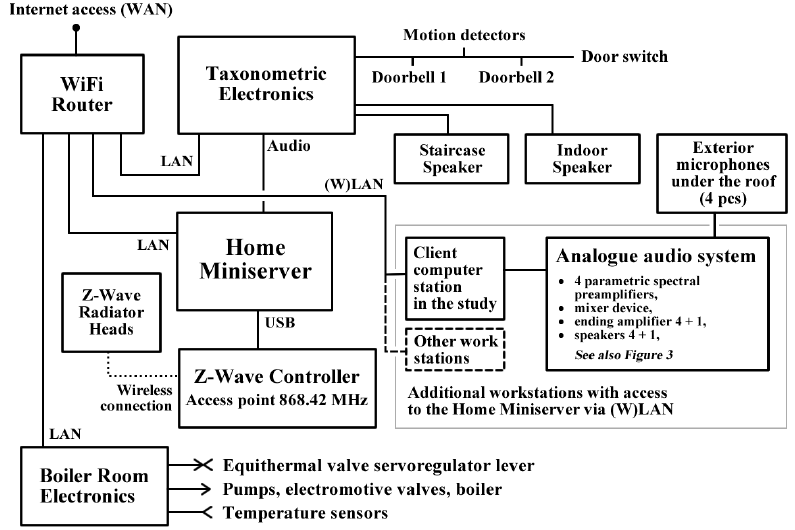
Figure 1. Block diagram of the main hardware components of RUDO system. This is the form in